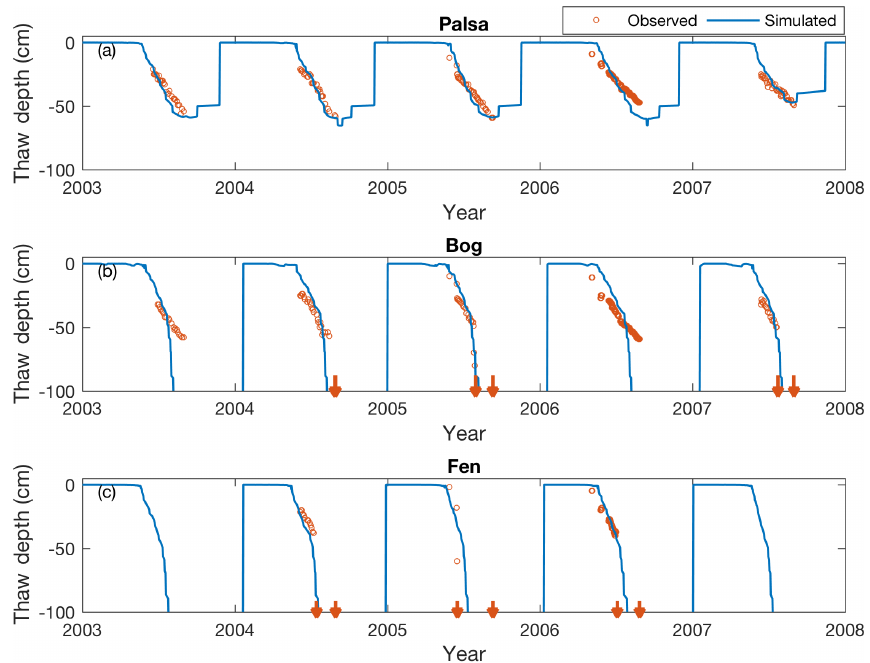
Figure 4. Simulated (solid lines) and measured (open circles) seasonal dynamics of thaw depth in the palsa (a) , bog (b) , and fen (c) sites from 2003 to 2007. Downward arrows indicate the time when measured thaw depth exceeds 90cm for a measurement year.